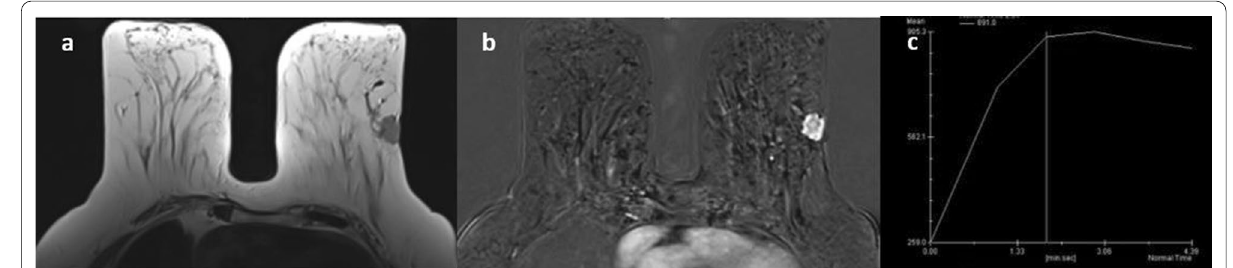
Fig. 5 A 65‑year‑old patient presented with left breast lump, pathologically proven to be invasive ductal carcinoma, NOS, grade III and